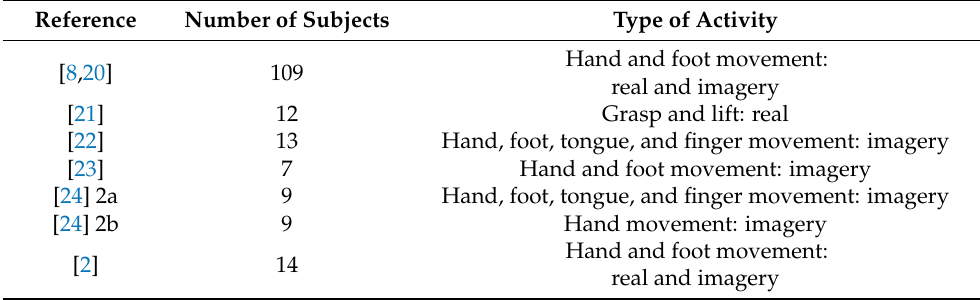
Table 1. Public databases containing EEG recordings of motor